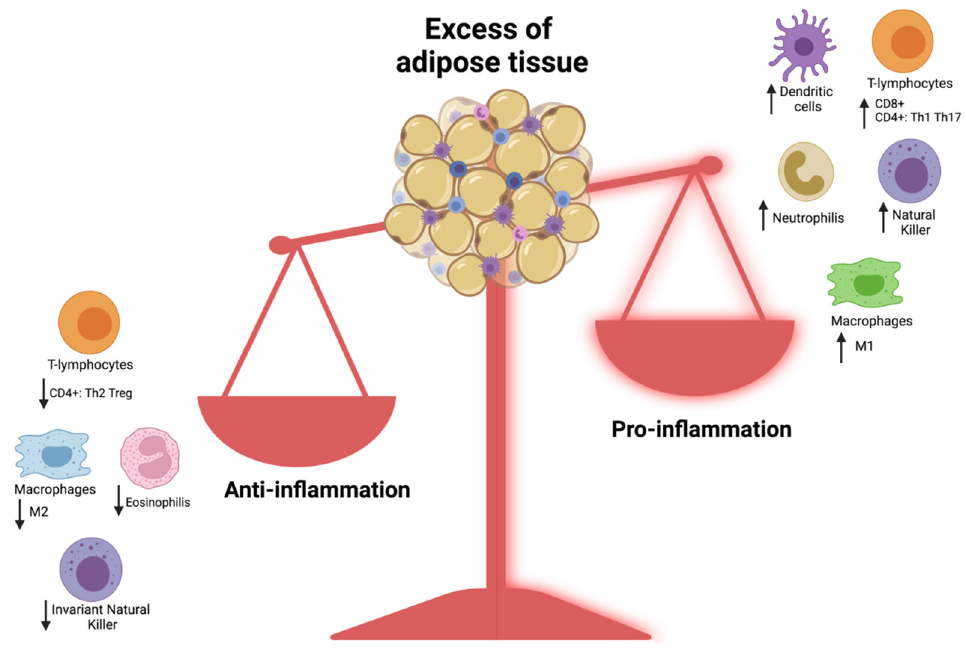
Figure 1. Pro-inflammatory and anti-inflammatory immune effects of excessive adipose tissue.